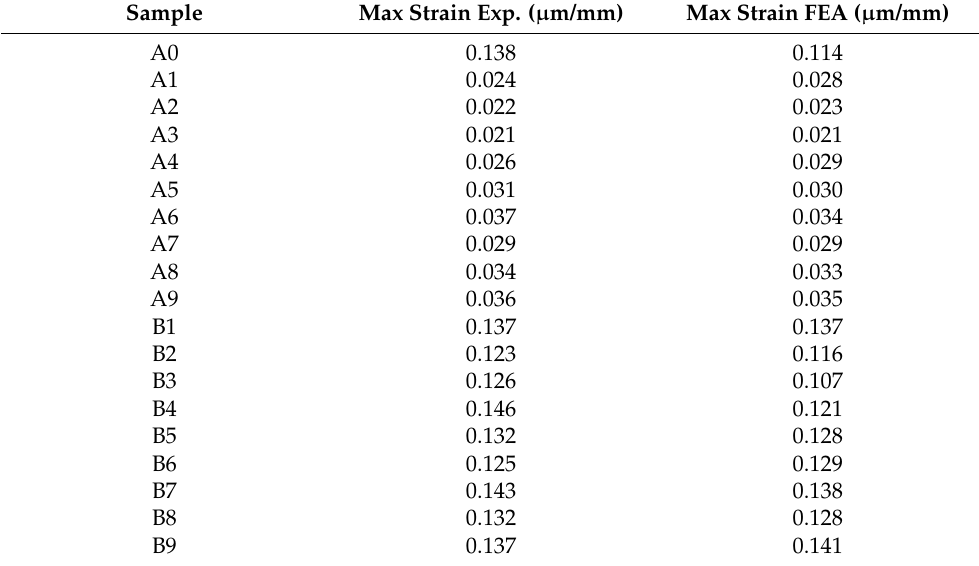
Table 13. Comparison between max strain results of the nineteen tested specimens.